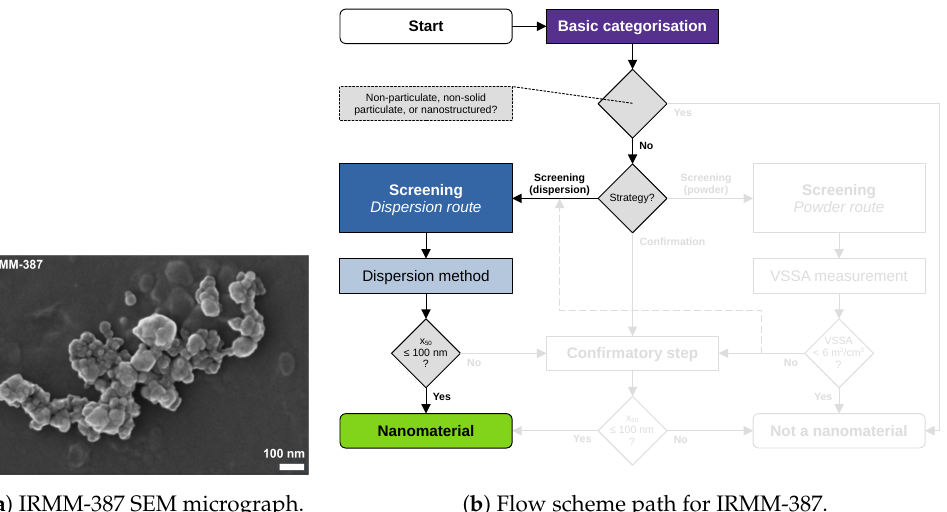
Figure 3. IRMM-387 (BaSO 4 , ultrafine grade): ( a ) representative SEM micrograph, and ( b ) respective flow scheme path. The tier 1 method DLS yielding an x 50 = 76 nm directly leads to a “nanomaterial” categorisation that was later checked as correct by